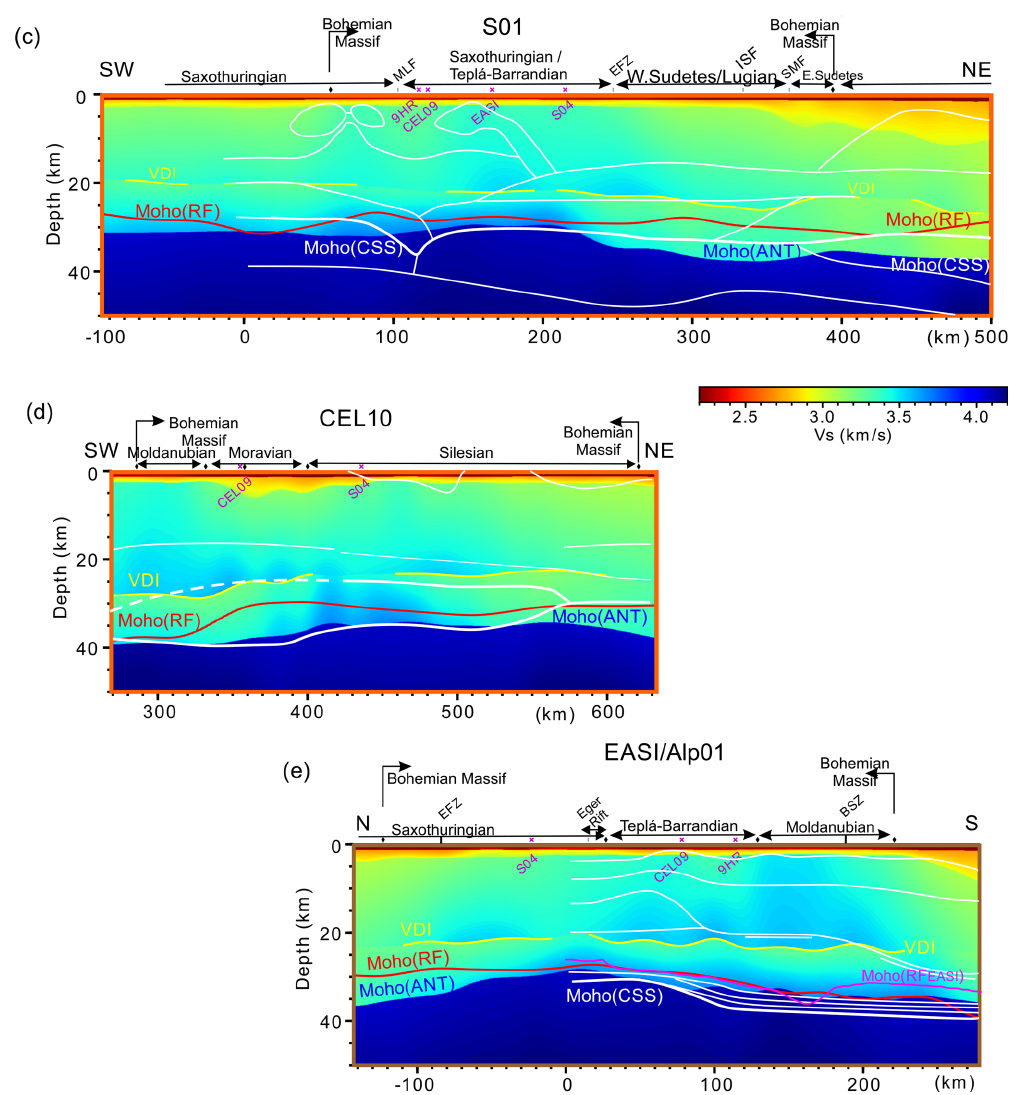
Figure 11. Cross sections through the 3-D v S ANT model (coloured background) along five CSS profiles. White lines mark velocity bound- aries according to the ALP01 (Brückl et al., 2007), CEL09 (Hrubcová et al., 2005), CEL10 (Hrubcová and ´Sroda, 2008), S01 (Grad et al., 2008), and S04 (Hrubcová and ´Sroda, 2010) CSS models (see inset for locations). The Moho depth, estimated from the Ps–P delay times in receiver functions calculated in this study for all of the stations, is shown in red. The magenta line in panel (e) is the Moho along